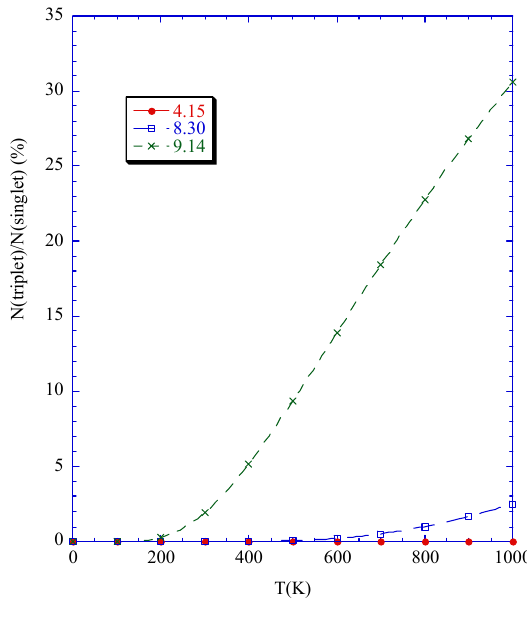
Figure 8. The proportion of triplet and singlet under the temperature 0~1000K. Each line is obtained from distorted structure d = 4.15, 8.30, 9.14%,